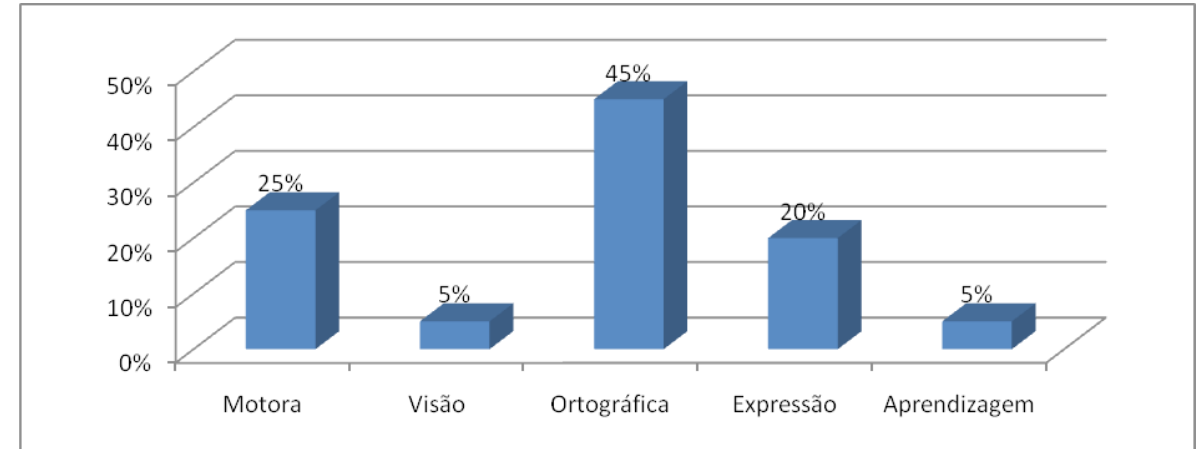
Figura 5. Dificuldades de escrita